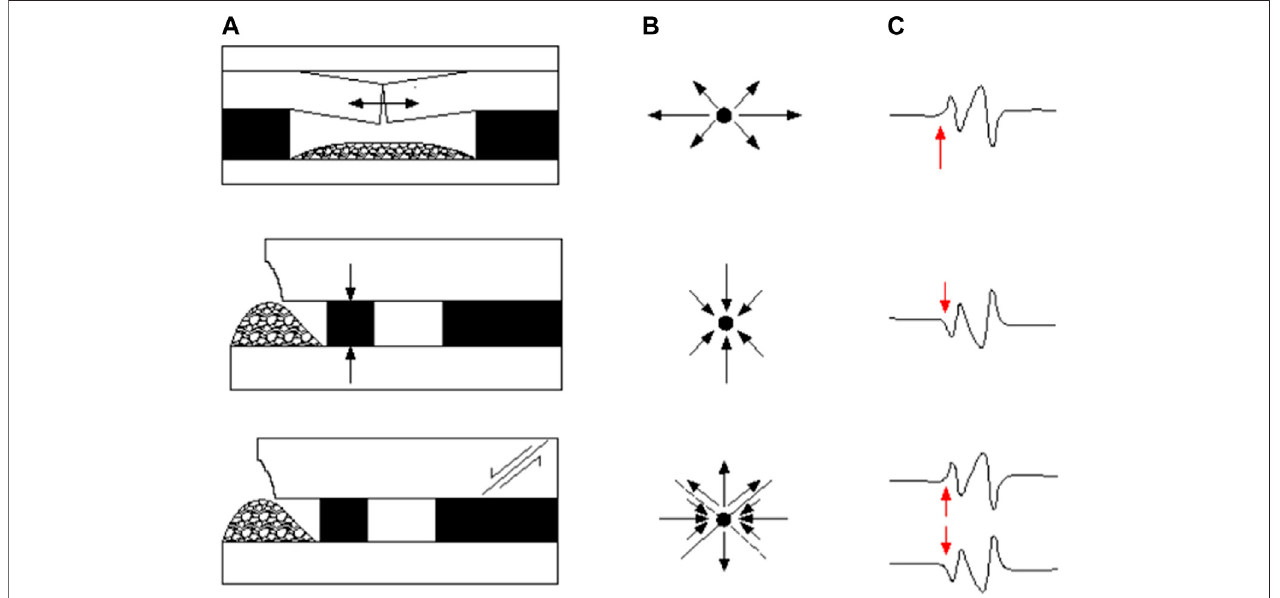
FIGURE 9 | Typical tremor model. (A) Types of mining-induced tremors; (B) Patterns of P-wave radiation; (C) Directions of P-wave fi rst